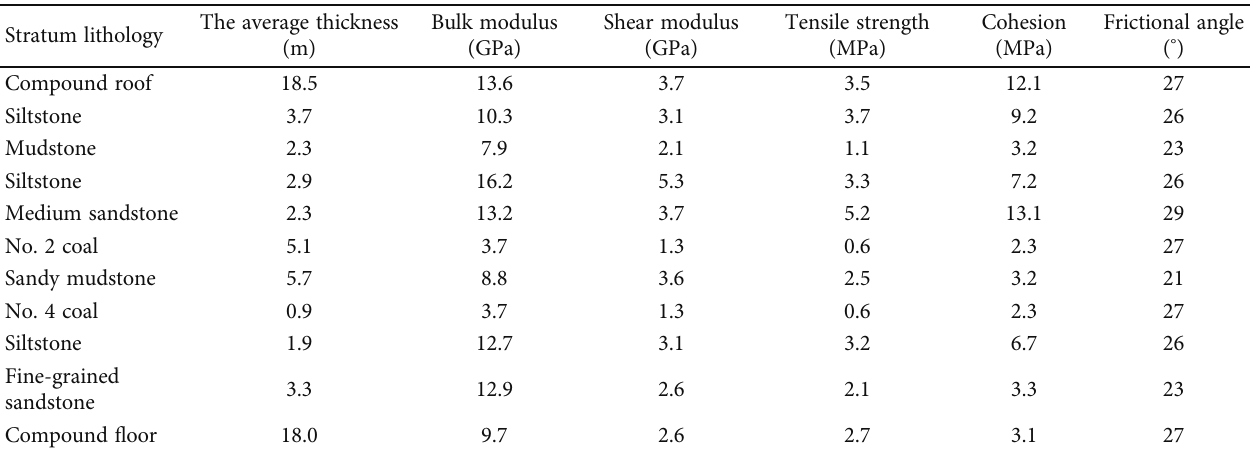
Figure 1: Layout of the No. 020202 panel of Qingyun coal mine. Table 1: Physical and mechanical properties of the surrounding rock.